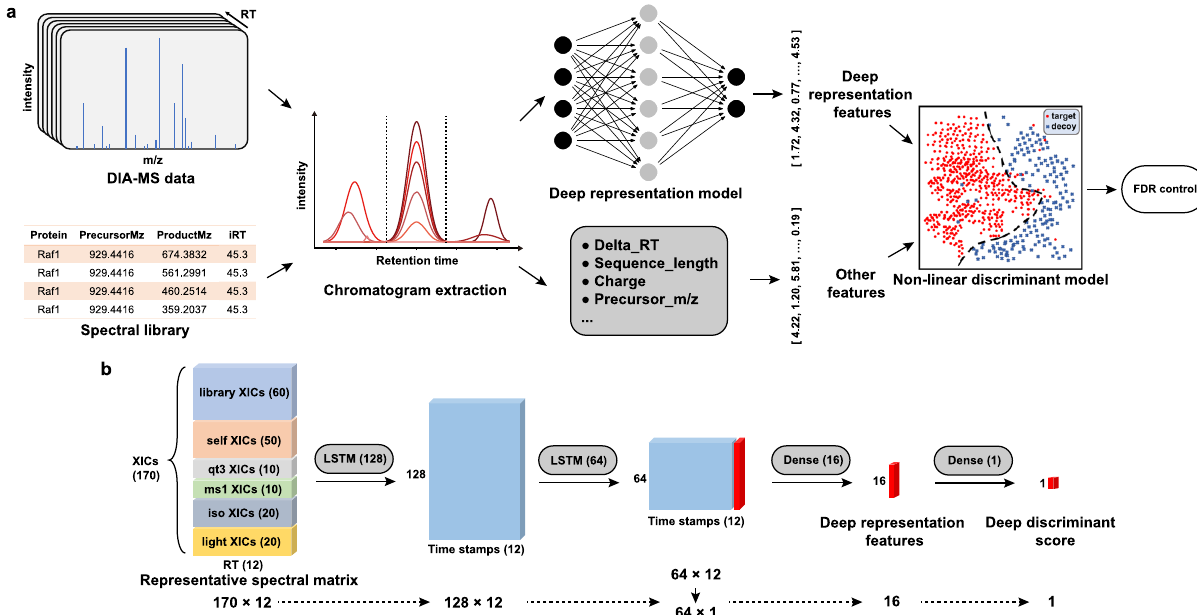
Fig. 1 Schematic illustration of DreamDIA. a Schematic diagram of DreamDIA. First, chromatograms of each target/decoy precursor and its corresponding fragment ions are extracted. Then the chromatograms are input to the trained deep representation model to calculate low-dimensional features. The deep representation features are further combined with other features, such as precursor m/z and charge, to calculate the fi nal discriminant score. b The deep representation model in DreamDIA. The input RSM consists of six types of XICs, namely, library , self , qt3 , ms1 , iso , and light XICs. The model contains two LSTM layers and two full-connected (FC) layers, through which the input RSM was transformed to the 16-dimensional deep representation features by the fi rst FC layer and to the deep discriminant score ( dds ) by the second FC layer.